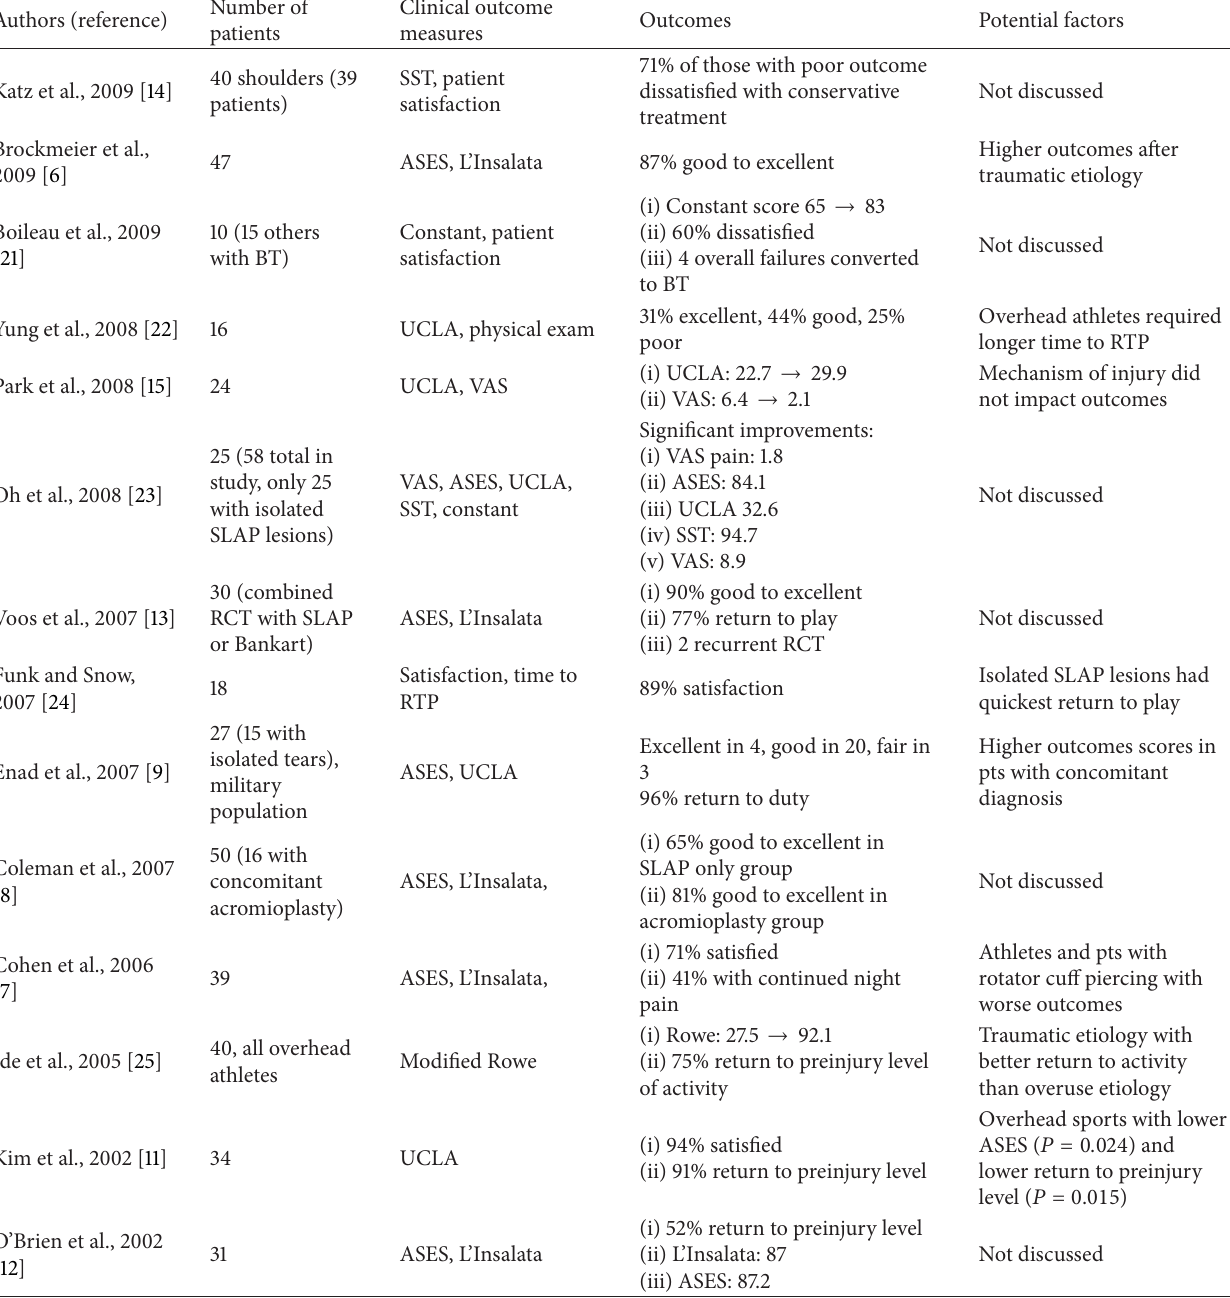
Table 2: Outcomes and potential contributing factors following arthroscopic SLAP lesion